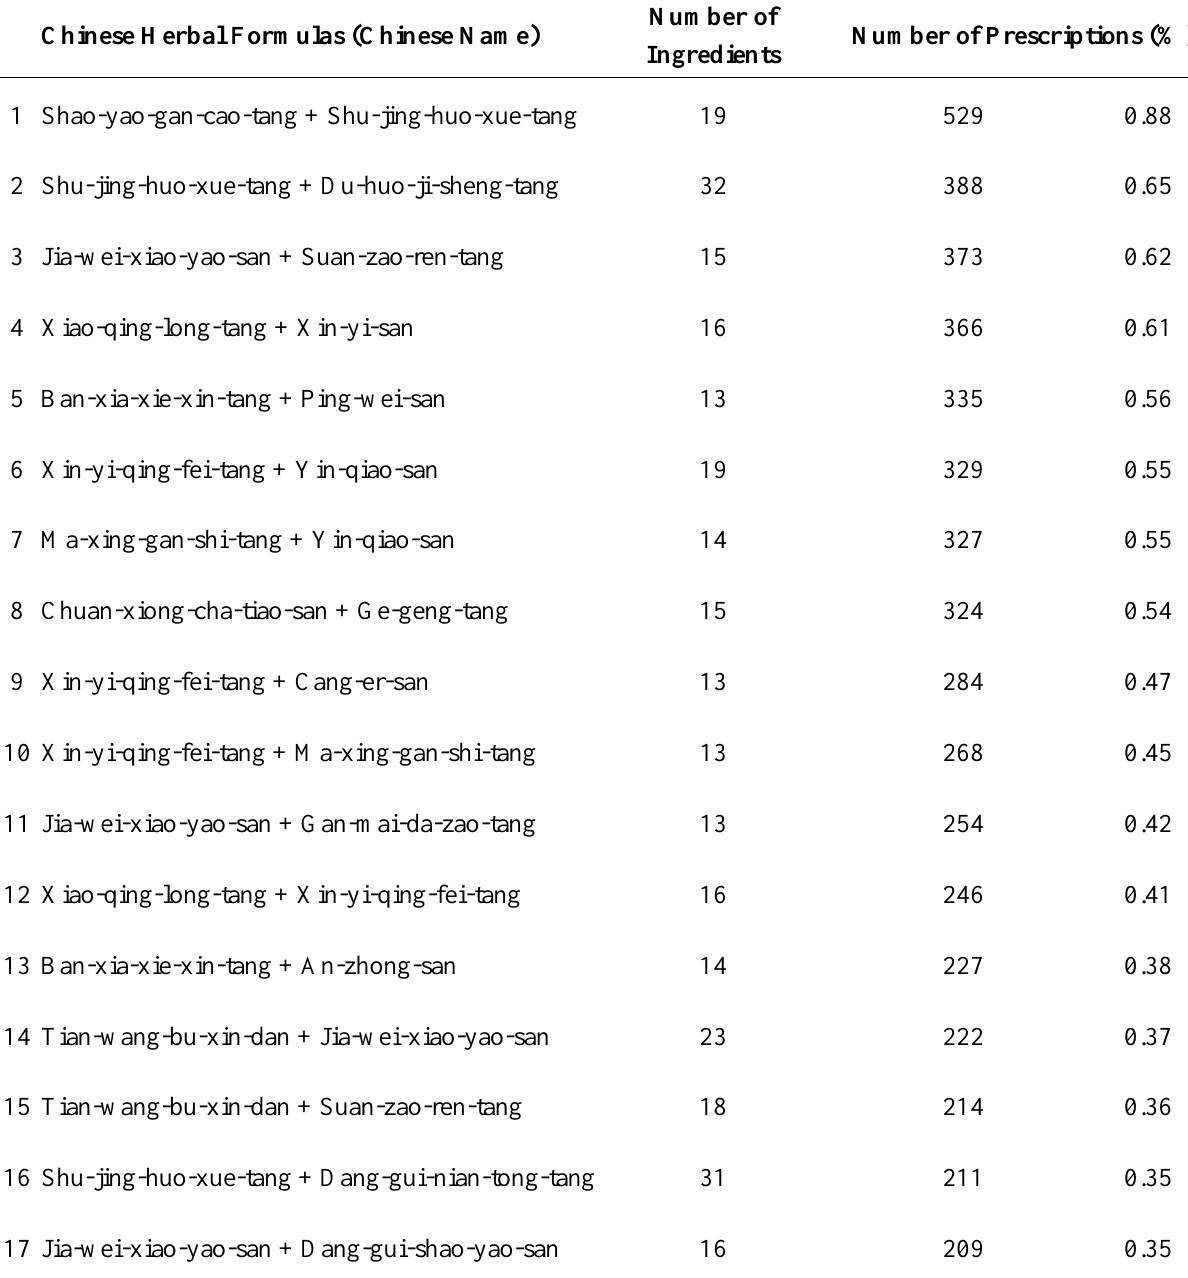
Table 5. The most common two-formula combinations of Chinese herbal medicine (CHM) in a single prescription in Taiwan in 2010 (total prescription number n =